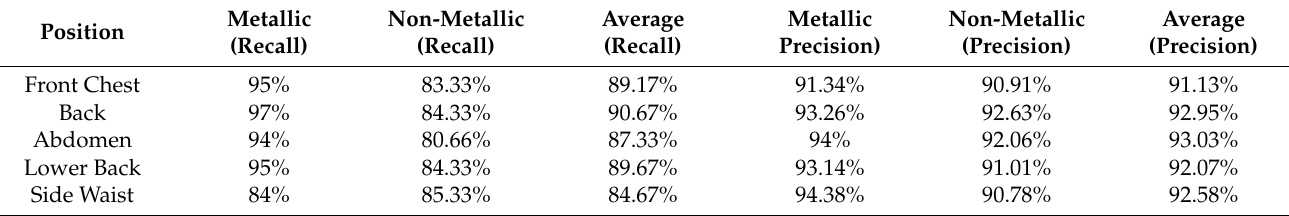
Table 6. Online Detection Result.